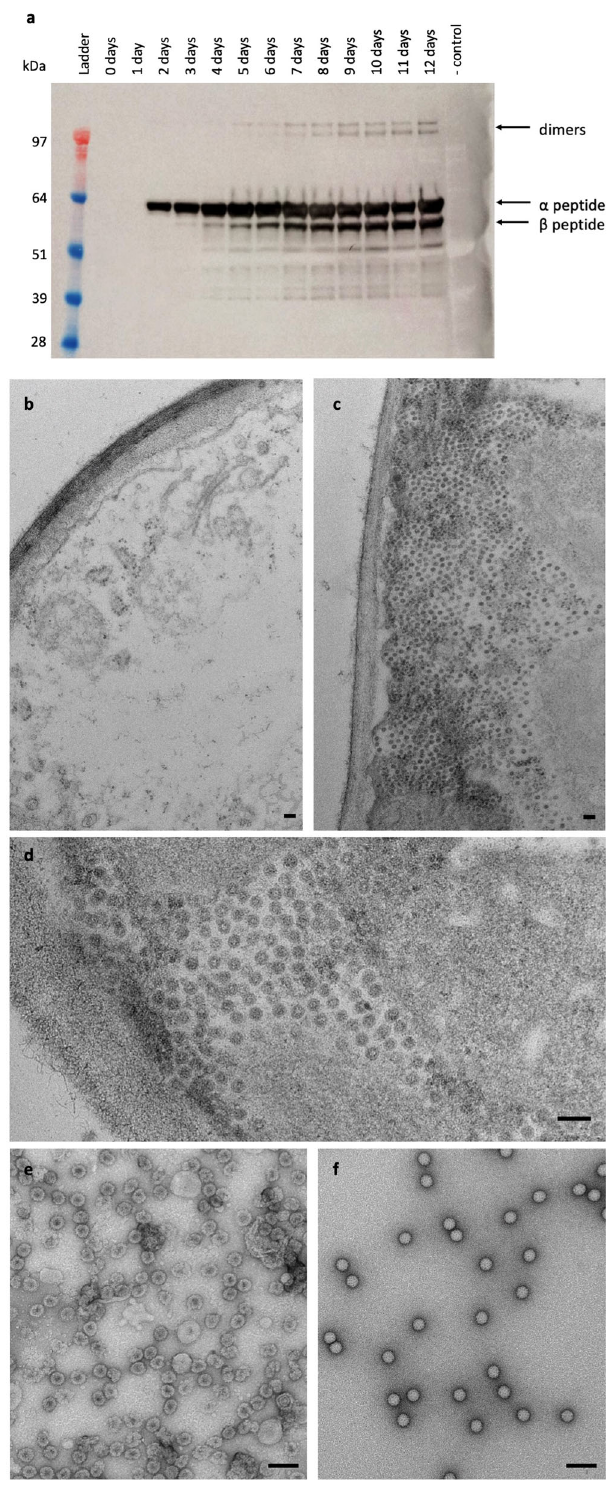
weight in fi ltrated leaf tissue.